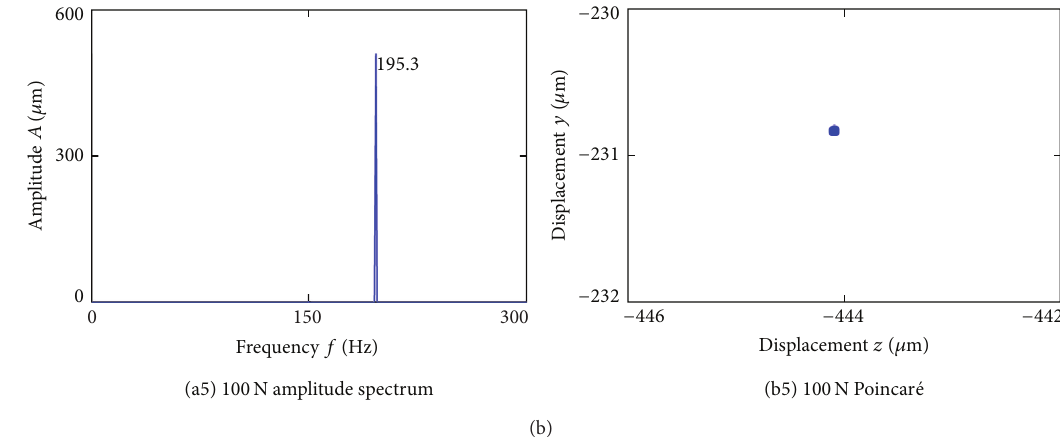
Figure 14: The amplitude diagram and Poincar´e mapping of tool point under different cutting